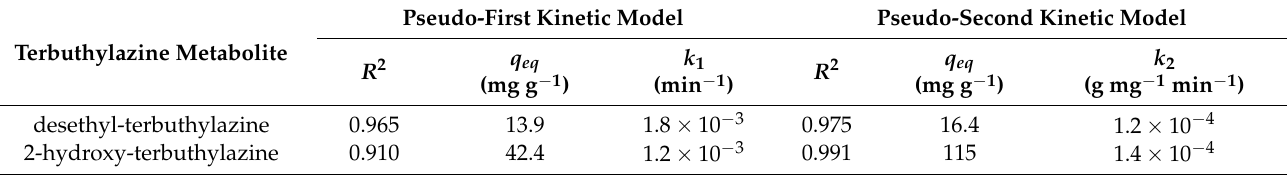
Table 2. Parameters of pseudo-first order and pseudo-second order adsorption kinetic model. Pseudo-First Kinetic Model Terbuthylazine Metabolite